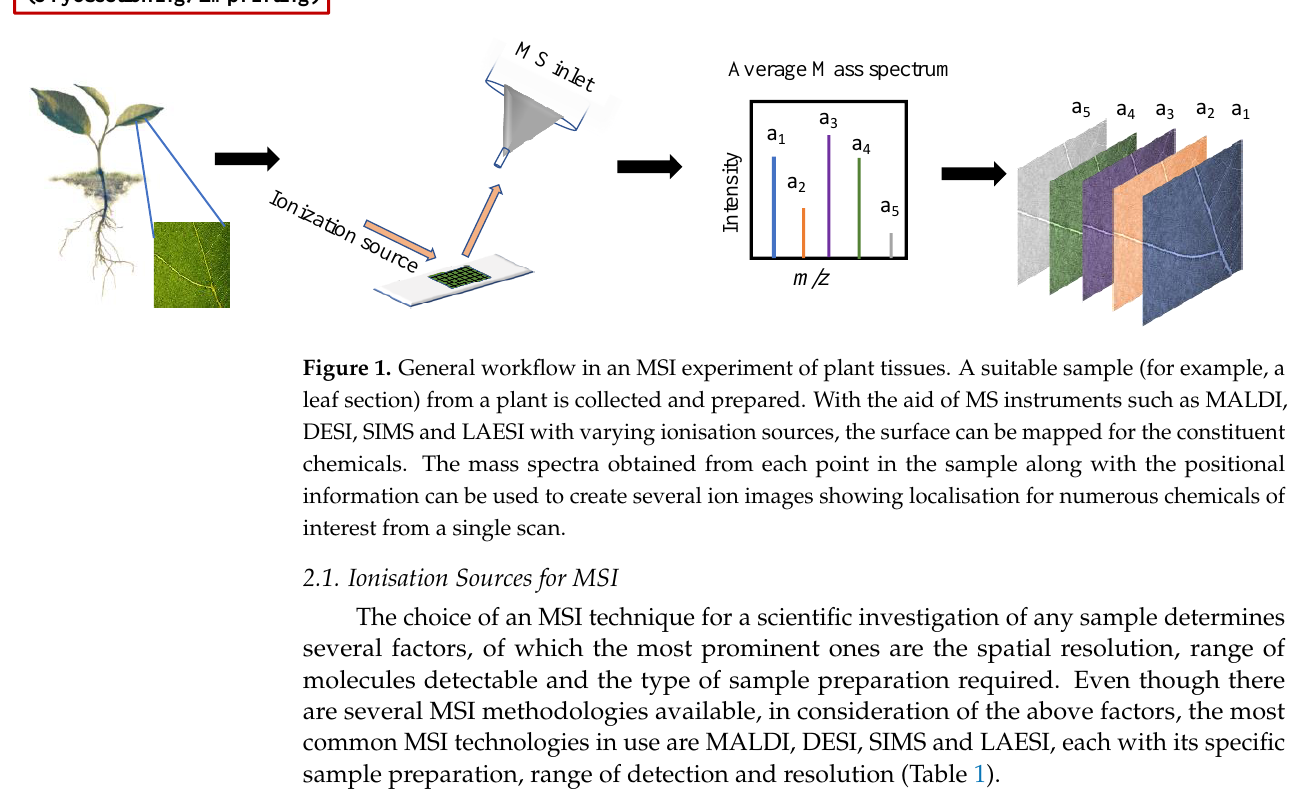
Table 1. MSI methodologies available for analysis of plant samples.